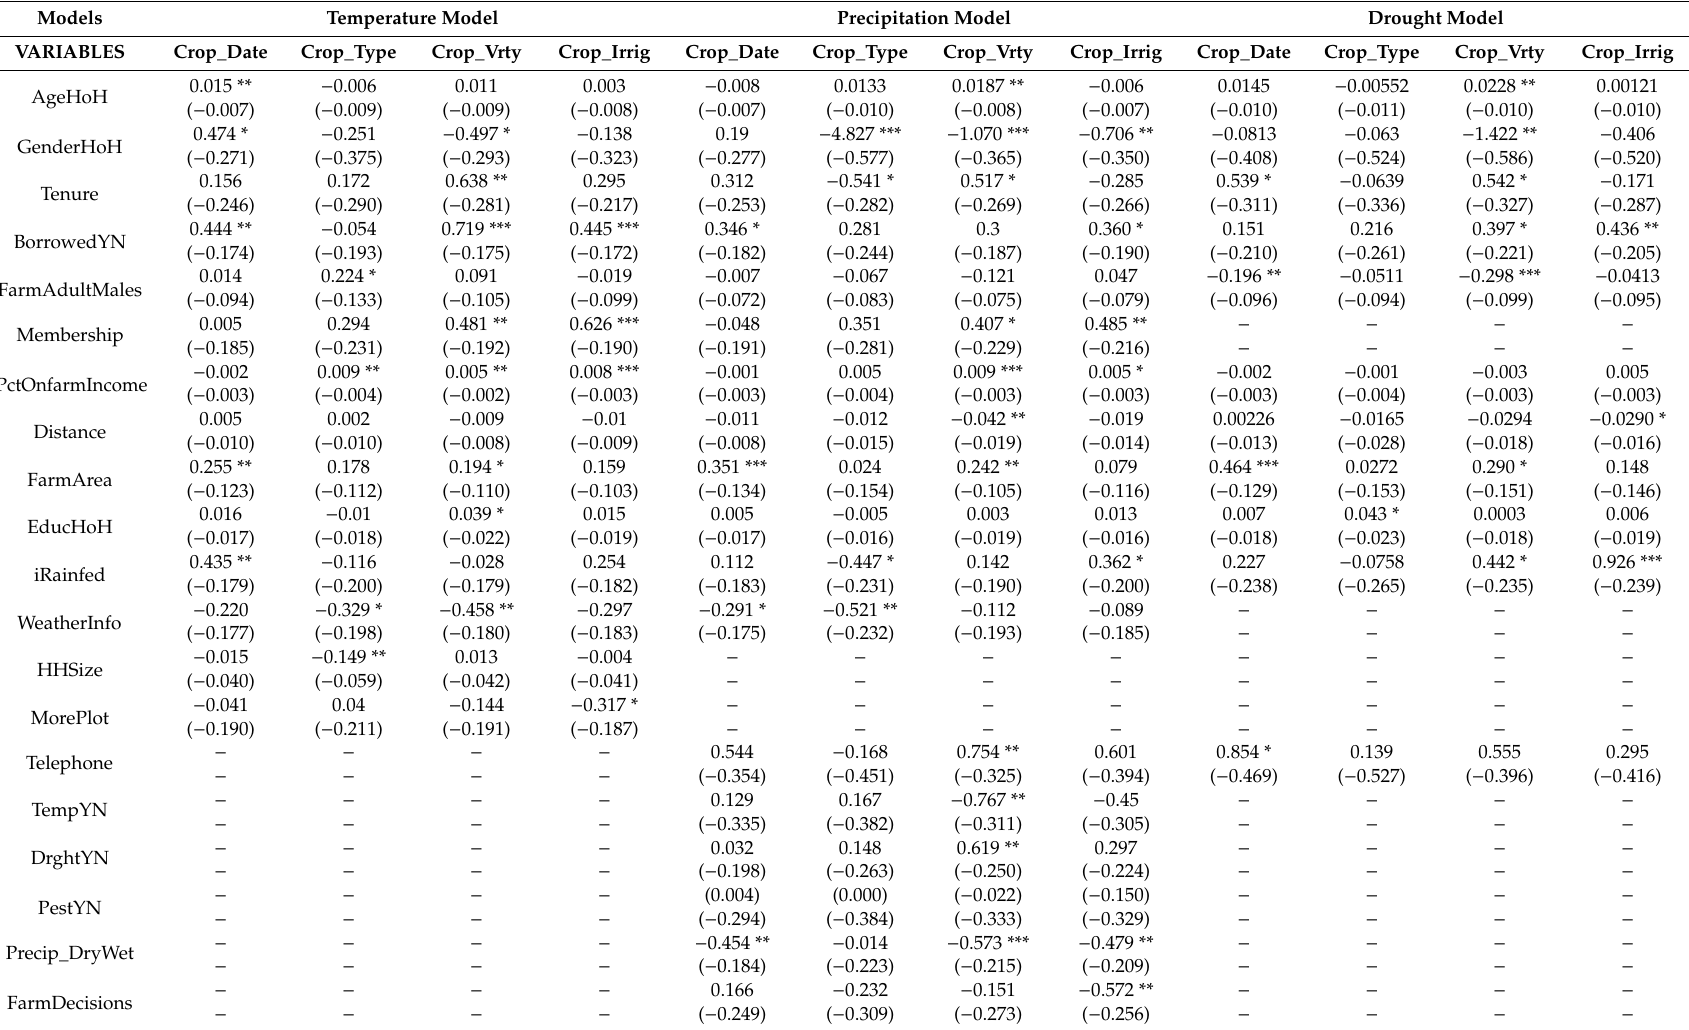
Table 3. Results of multivariate probit model (MVP) analysis of determinants of